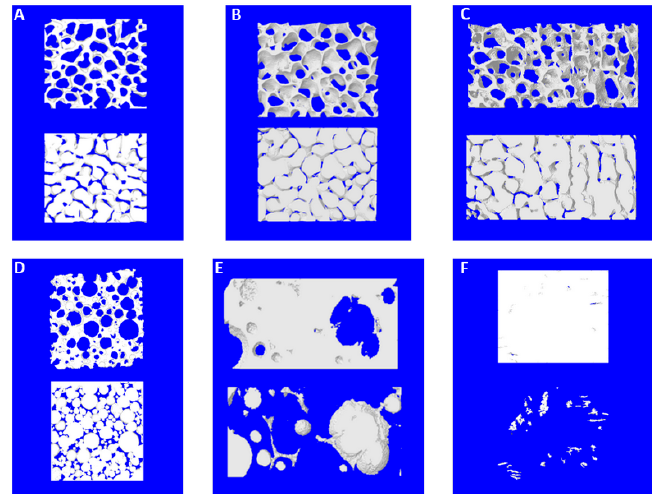
Figure 2. 3D images of selected parts of the samples, each image shows the positive (upper part) and negative (lower part): ( A ) BioOSS ® , 1a; ( B ) Biogen ® , 1b; ( C ) ICB; ( D ) ENGIpore ® , 2b; ( E ) Bioset, 3a and ( F ) SINTbone, 4a.